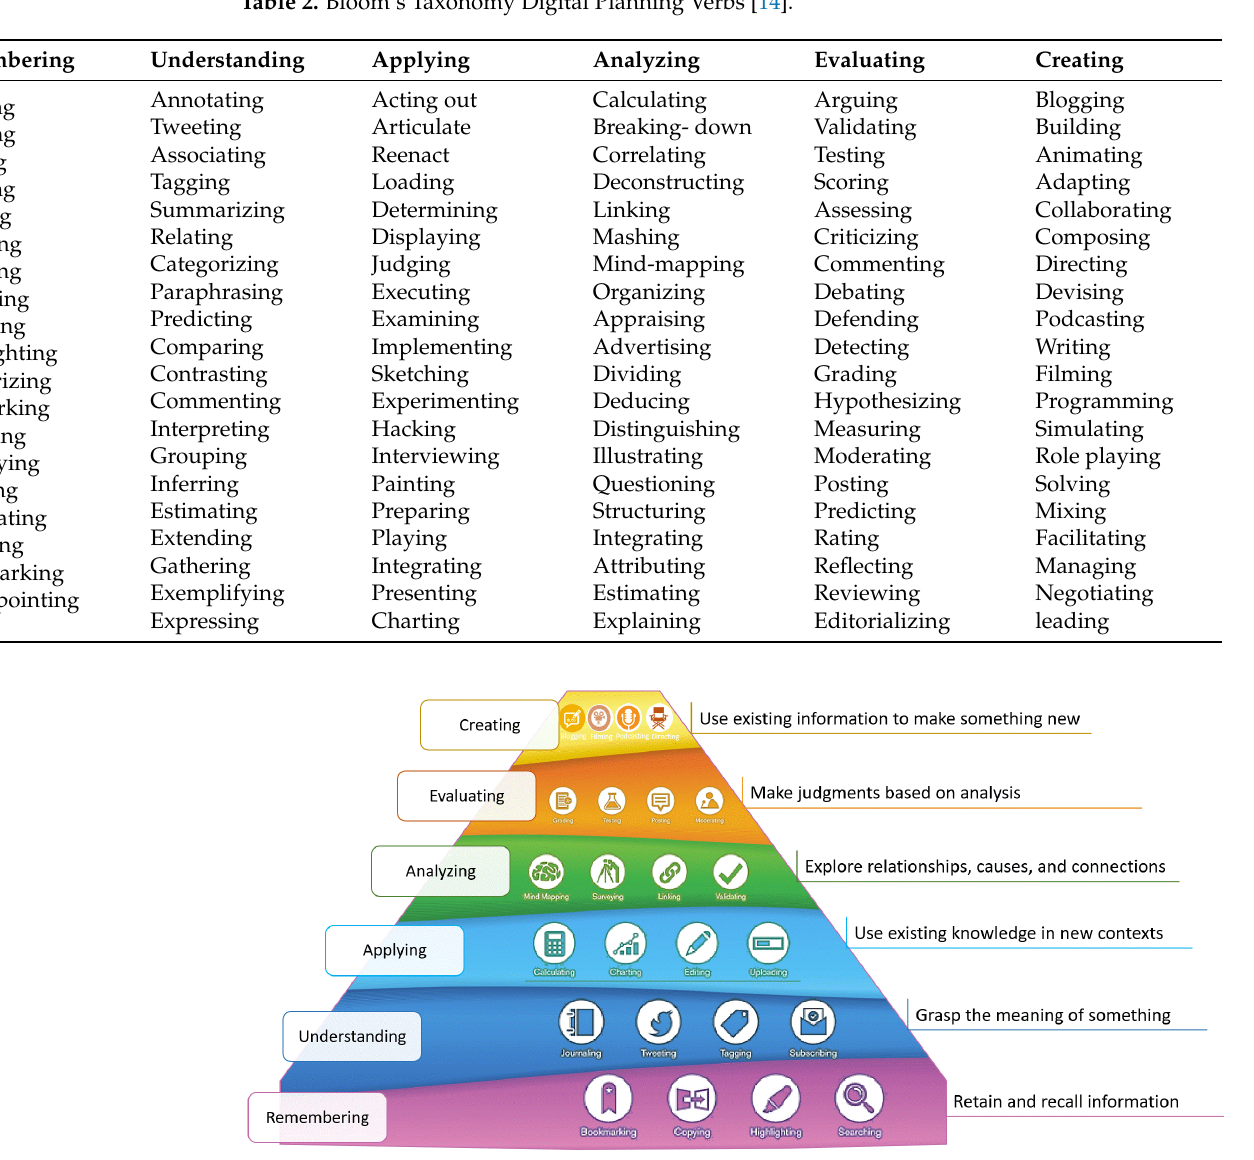
Figure 4. Bloom’s Taxonomy: activities with digital tools